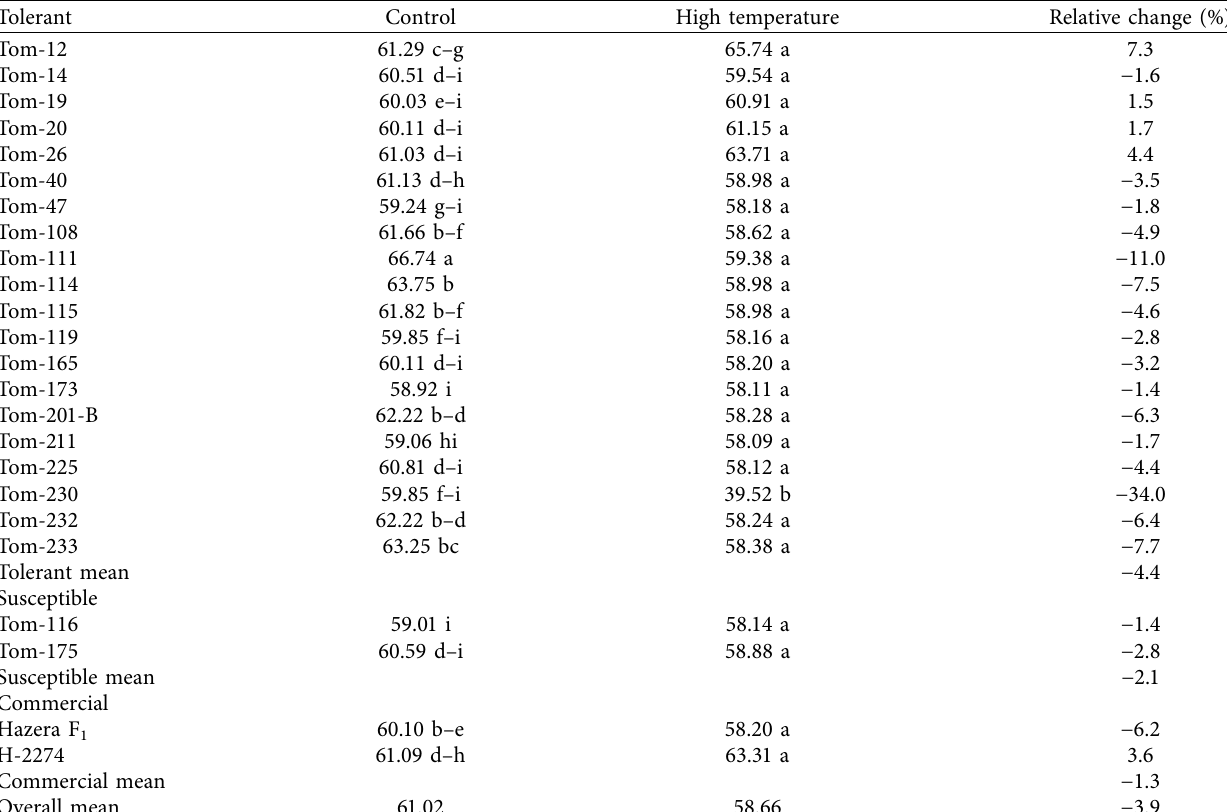
Table 10: Lycopene content of tomato fruits grown in control and high temperatures (mg/100g FW).